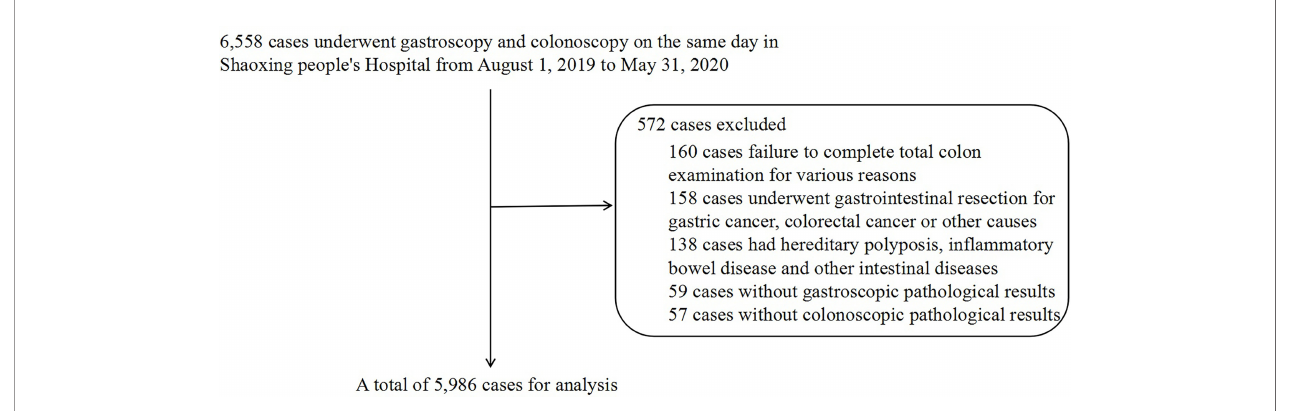
FIGURE 1 | Flowchart of case